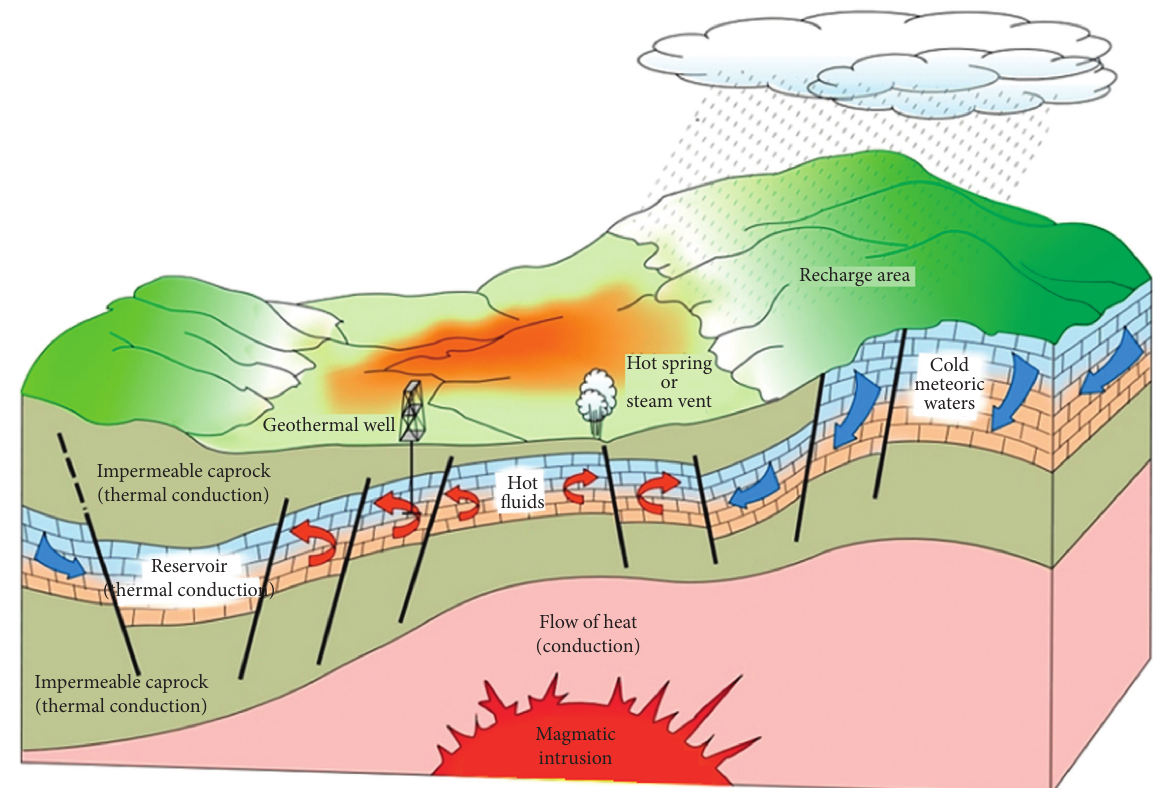
Figure 2: Schematic diagram of an ideal geothermal system (cited from Huenges, 2016